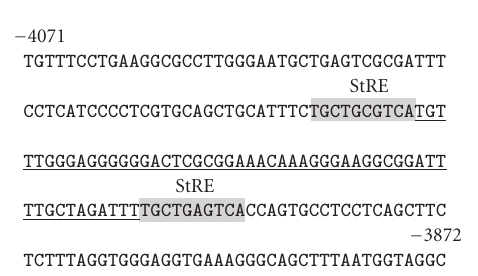
Figure 1: The DNA sequence selected for prescreening. A 54bp DNA sequence between the two stress response elements (StREs) of human HMOX1 enhancer (underlined) was selected for prescreen-